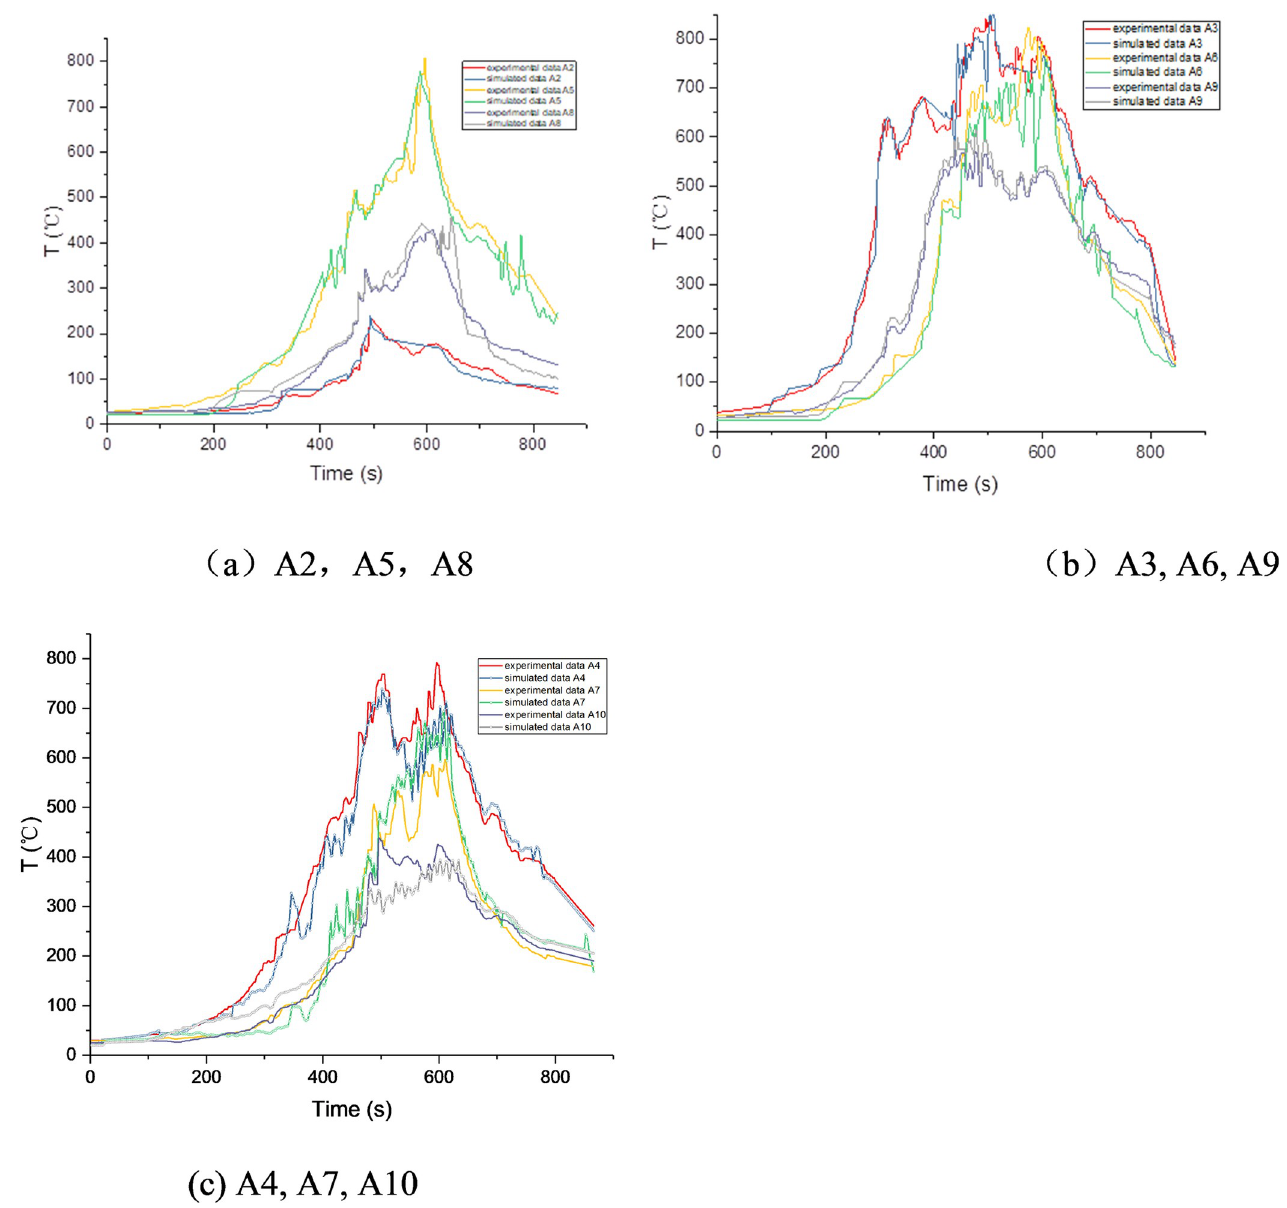
Fig 9. Comparison between experimental and simulated smoke